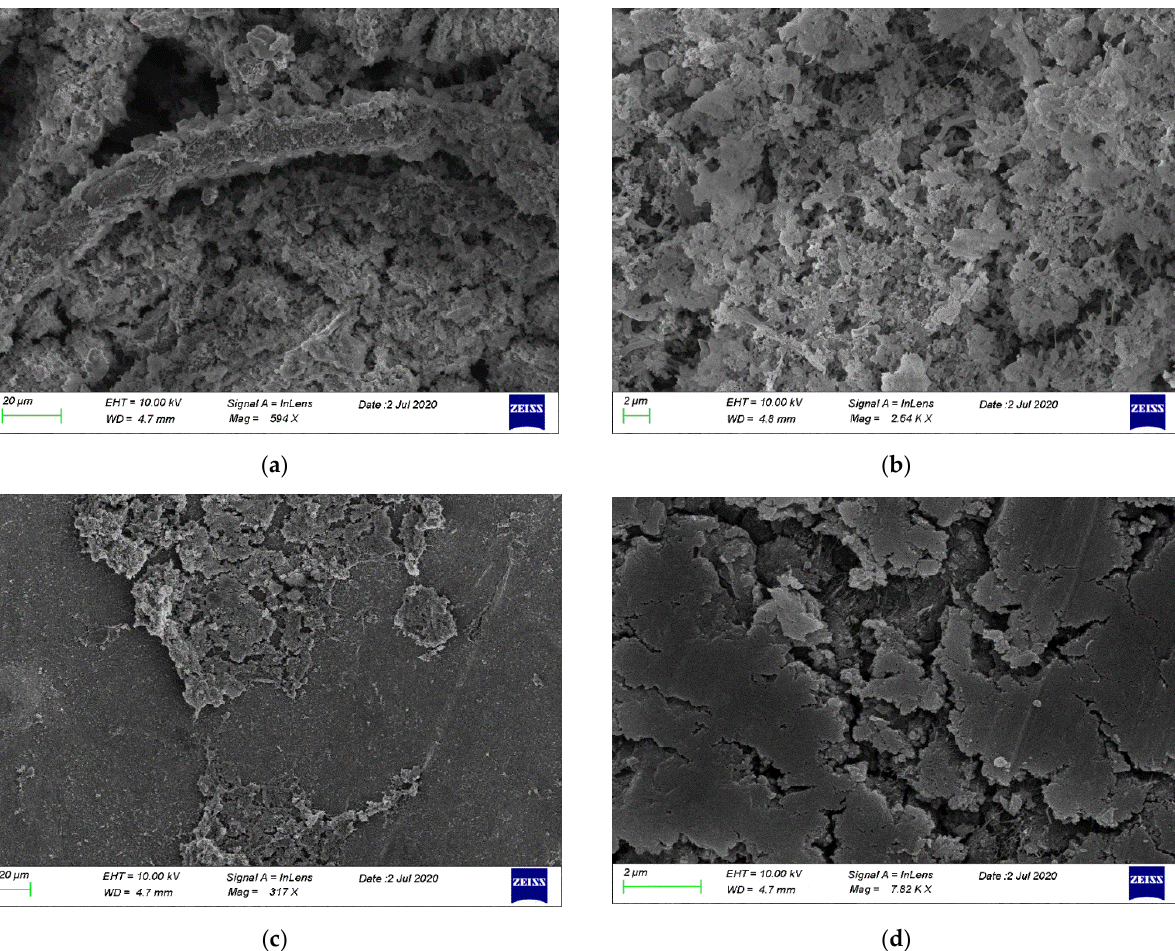
Figure 8. SEM images (top view) of both anodes at the end of the cycle with DF effluent feed. ( a , b ) MEC1 and ( c , d ) MEC2. It has been shown that the biofilm viability and hydrogen evolution, can for different bacteria, be affected by the hydrophobicity/hydrophilicity of the anode. The hydrophilic- ity/hydrophobicity of CNT-buckypaper and commercial CP was evaluated (Figure 9) with contact angle measurements using a drop of water on their surface. The contact angle is ca. 46° for CNT-buckypaper while for the CP is ca. 128°. These results indicate high wet- tability for CNT-buckypaper, thus confirming the best hydrophilic behavior. These results are consistent with the results of De-la-Pinta et al. [44] who assessed the effect of rough- ness and hydrophobicity of different biomaterials on the biofilm formation of different microorganisms. Based on their study, hydrophobic materials led to more abundant and profuse biofilms and their influence was more significant in the formation of biofilm than the roughness of the biomaterials.